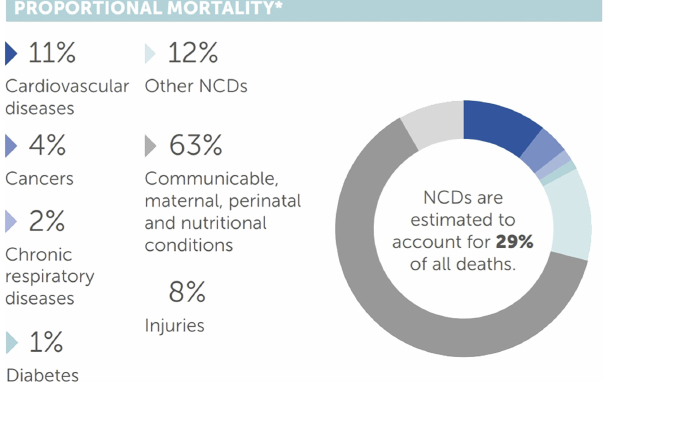
Figure 3. Risk of premature